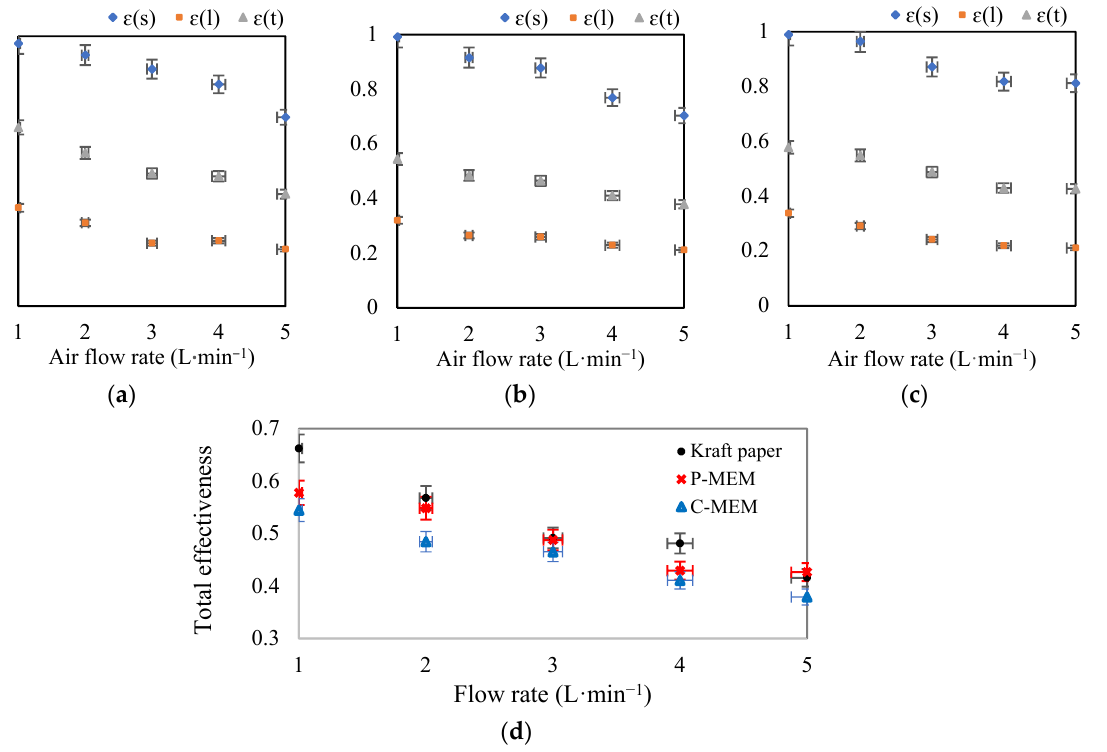
Figure 4. Effect of increasing air flow rates on sensible, latent, total effectiveness for ( a ) kraft paper, ( b ) C-MEM, and ( c ) P-MEM, and ( d ) comparison of the total effectiveness of different membranes at different air flow rates.